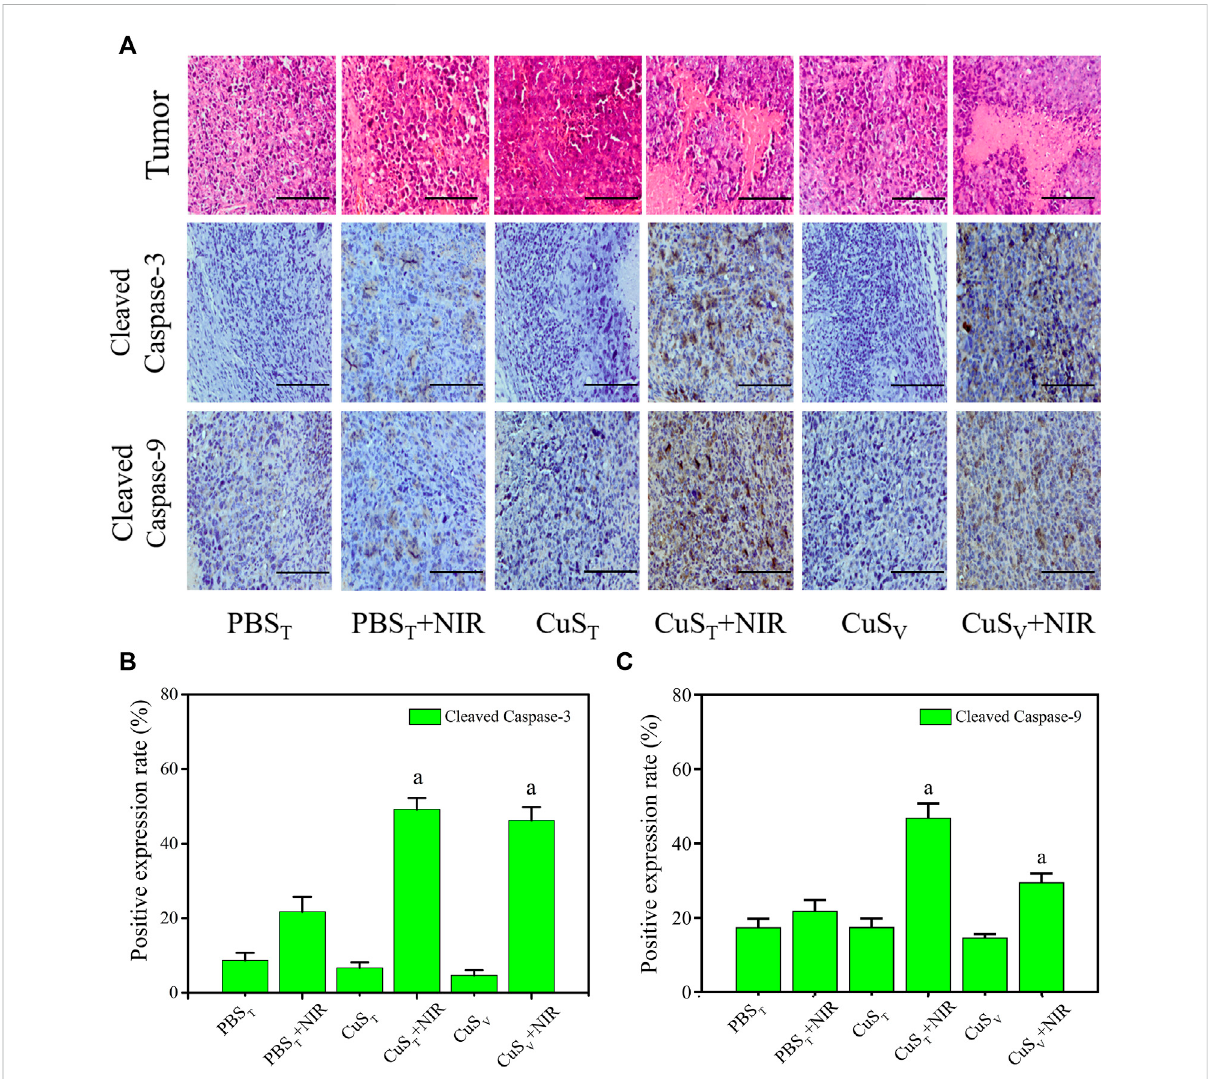
FIGURE 7 Apoptosis level of tumor tissue cells after photothermal therapy. (A) Pathological section of tumors with hematoxylin-eosin staining (the fi rst line)andimmunohistochemistrysection(therestlines).Scalebarsrepresent100 μ m. (B) and (C) Quantitativeanalysisofimmunohistochemistry(N= 3 per group). a: compared with the PBS T + NIR group, p <